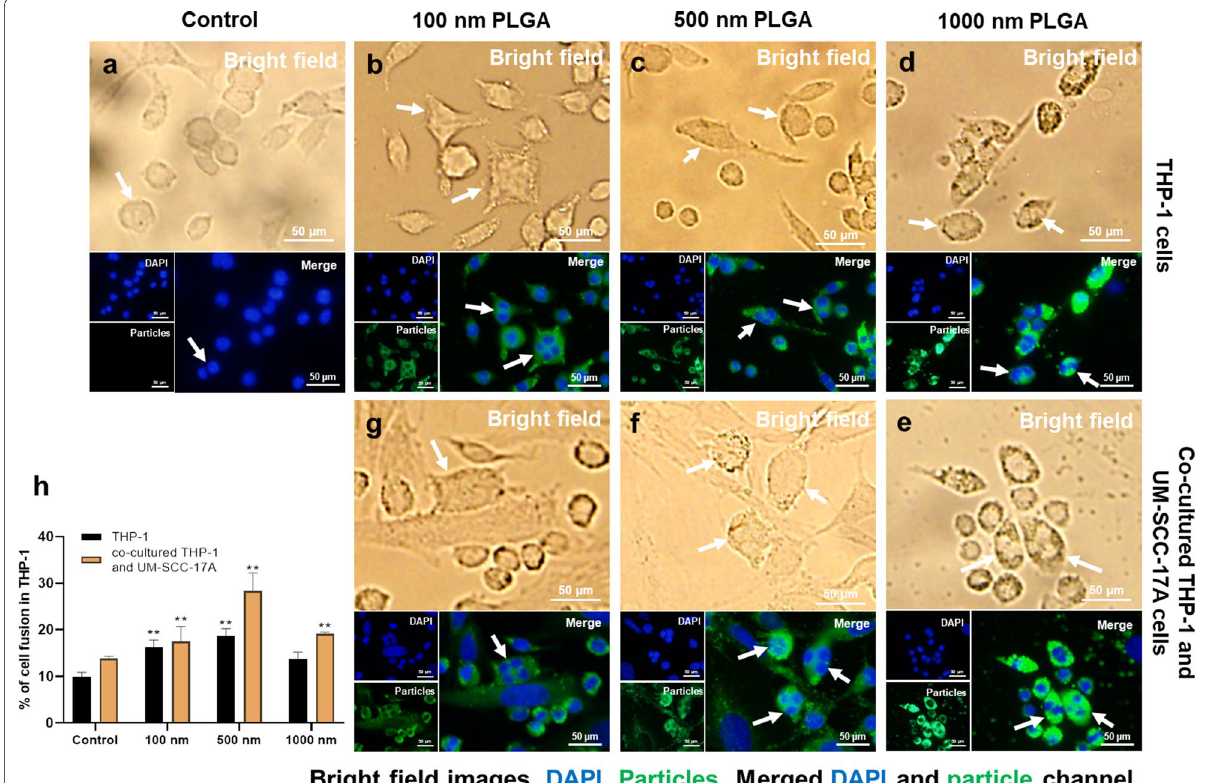
Fig. 9 Visualization and quantification of THP‑1 cell fusion in monoculture and co‑culture systems. Cell fusion occurred in all groups including the control group without particle treatment for THP‑1 cells ( a ). Monocultured ( b , c ) 100 nm and 500 nm NP‑induced significant cell fusion compared to 1 µm PLGA group ( d ), which has a slightly higher level than that of the control group. In co‑cultured systems, 100 nm ( g ) and 1 µm ( e ) PLGA had an identical percentage of cellular fusion, which is apparently smaller than that of 500 nm group ( f ). Quantification of cell fusion for all groups after 24 h incubation was displayed in